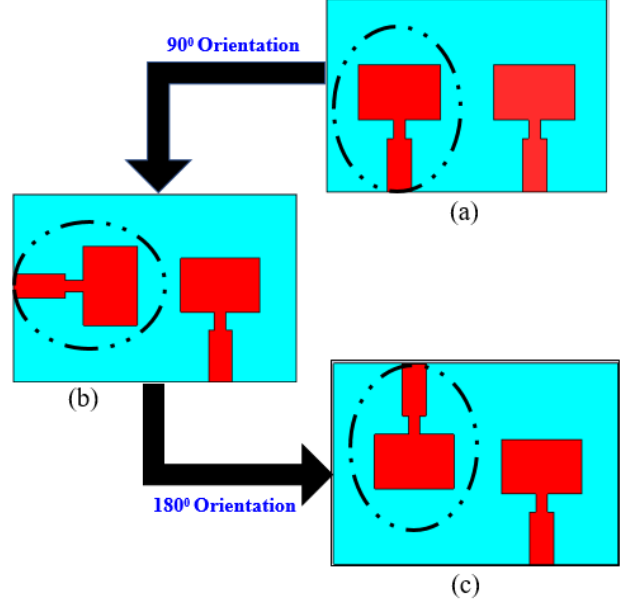
Figure 8. The proposed three different MIMO antenna configurations ( a ) 0 ◦ orientation, ( b ) 90 ◦ orientation, ( c ) 180 ◦ orientation.